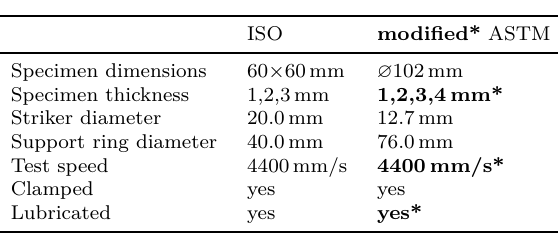
Table 1. Selected test conditions and parameters.